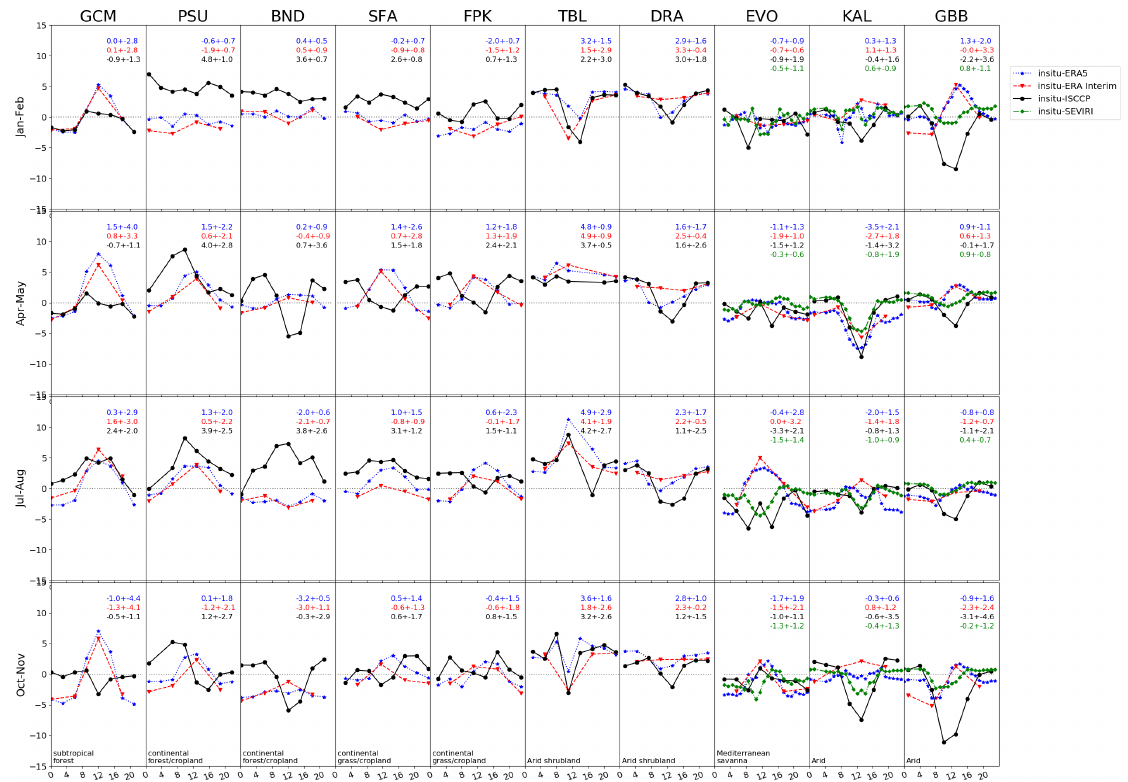
Figure 9. Diurnal variations of monthly mean differences of LST (unit: K) at selected stations, i.e., In situ—ERA5, In situ—ERA Interim, In situ—ISCCP and In situ—SEVIRI (when available). X -axis represents local